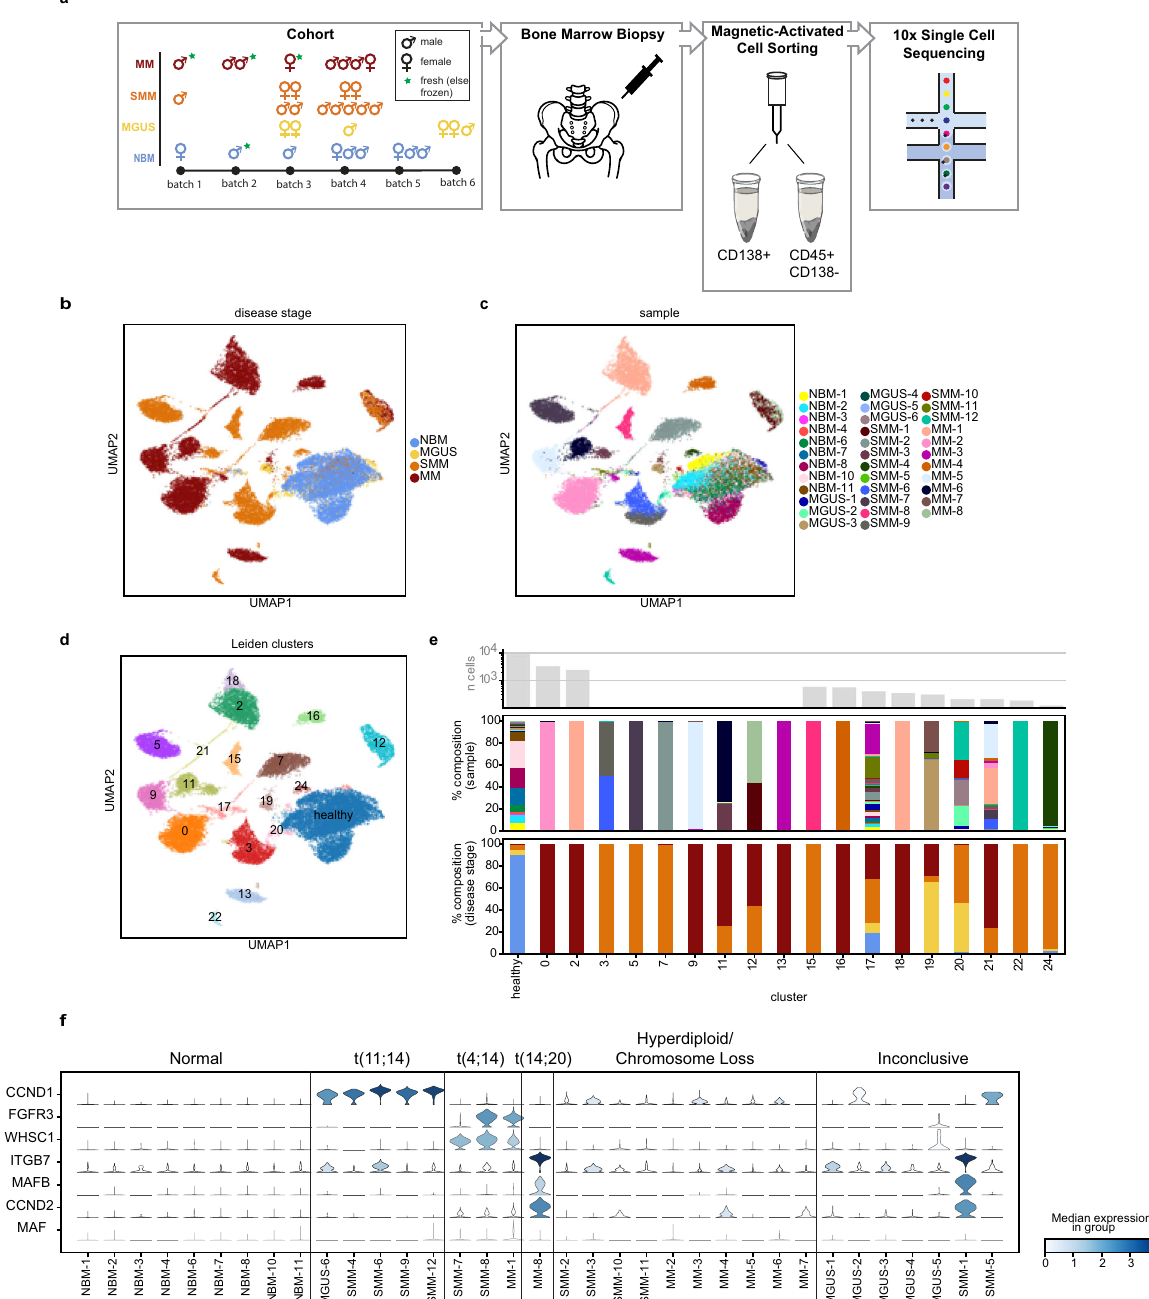
Fig. 1 | The landscape of normal and abnormal plasma cells at single cell resolution.a Overviewofcohortandexperimentalsetup,includingthenumberof samplesperdiseasestage,sex,samplepreparationbatch,andwhetherthesample was fresh or stored frozen prior to 10x sequencing. CD138+ bone marrow cell fractionswereisolatedandareanalyzedinthisstudy. b , c UMAPrepresentationof plasma cells colored by disease stage ( b ) and sample ID ( c ). Cells similar in expression pro fi le are placed nearby in this embedding. d Results of Leiden